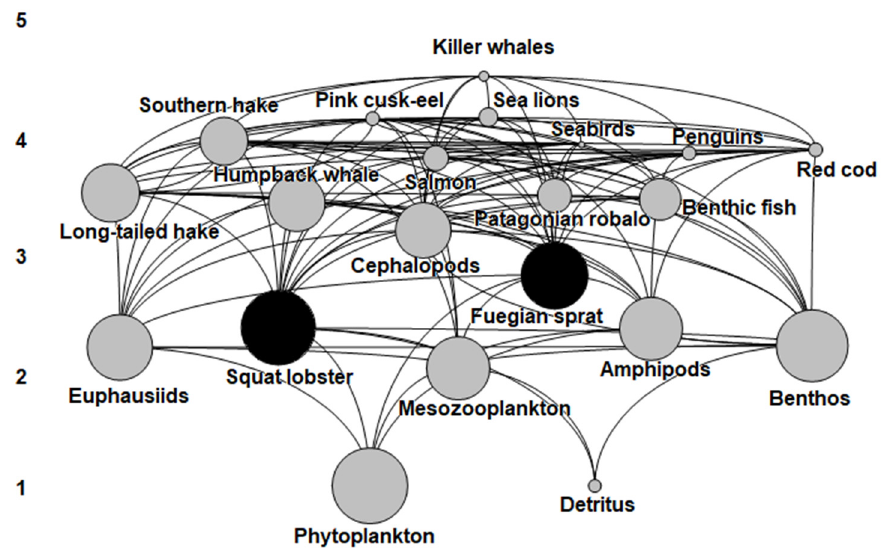
Figure 2. Ecosystem flow diagram of the Francisco Coloane Marine Area. Groups are distributed on the vertical axis according to their trophic level (i.e., 1–5). The circles are proportional to the functional biomass size of the groups. Squat lobster and Fuegian sprat groups are in black. Table 4. Trophic level and functional indices of each ecosystem group in the Francisco Coloane Marine Area ecosystem.